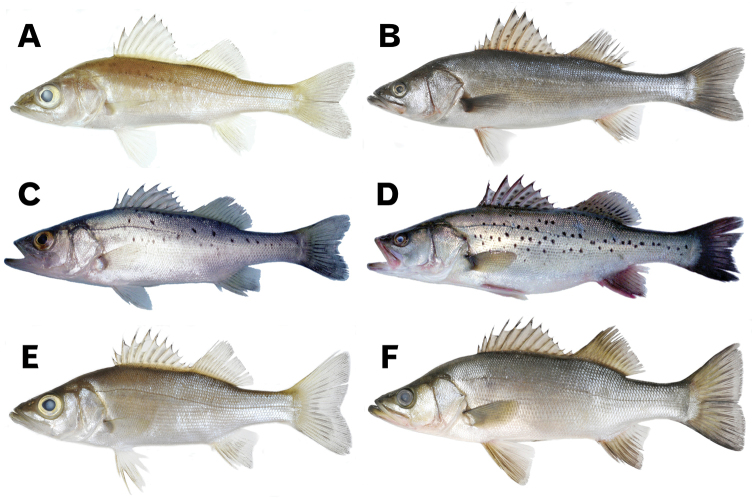
General aspects of small (fingerling) and large (adult) individuals of Lateolabraxjaponicus (A, B), L.maculatus (C, D) and L.latus (E, F) in fresh condition. AKPM-NI 27449 (91.9 mm SL) BKPM-NI 30671 (331.0 mm SL) C uncatalogued specimen (94.3 mm SL) DBSKU 100776 (265.0 mm SL) EKPM-NI 29044 (97.1 mm SL) FKPM-NI 24656 (369.0 mm SL). A, B, E and F were photographed by Hiroshi Senou (KPM), C and D were photographed by K. Yokogawa.